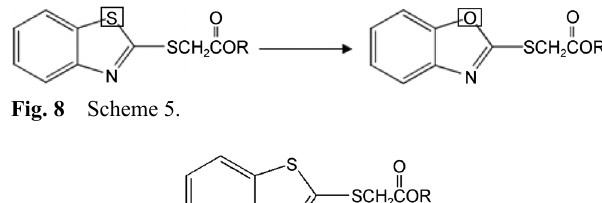
Fig. 2 The structural formula of the compound.